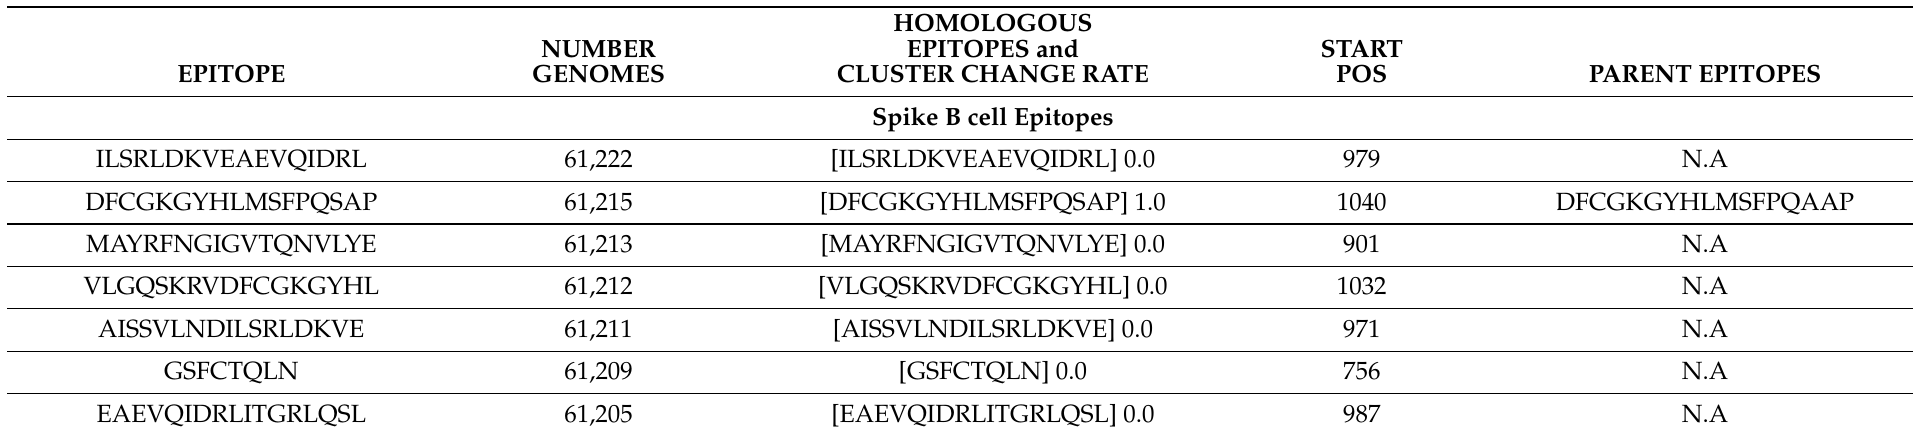
Table 3. Top 10 most commonly found epitopes in Spike glycoprotein sequences. Here, frequency of occurrence is determined by calculating the number of unique genomes an epitope is present in. Homologous epitopes are sister epitopes that cluster together with the epitope in first column when performing clustering by sequence. The cluster change rate indicates the probability of a candidate epitope being found in the cluster. If the cluster consists of only lab confirmed epitopes, the evolution rate will be 0. Start pos is the index of the starting position of epitope on aligned protein sequences, as noted in Section 2.8.1 and in case of every epitope matches the median start position on unaligned sequences. * in front of the sequence indicates that the sequence was found to be a MHC CLass I epitope in majority assays listed on